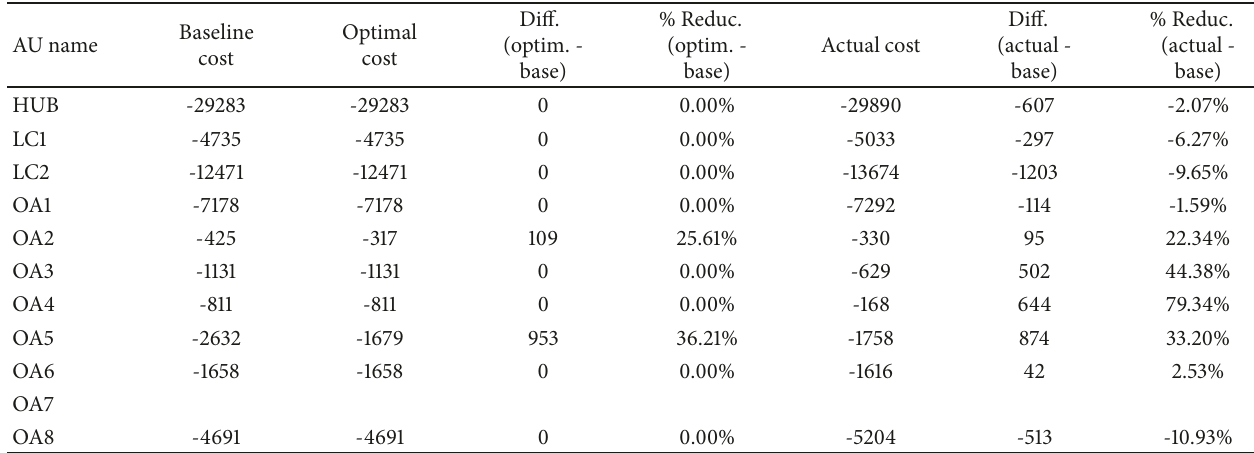
Table 9: Effect of sequence compression on the AUs actual costs (case study